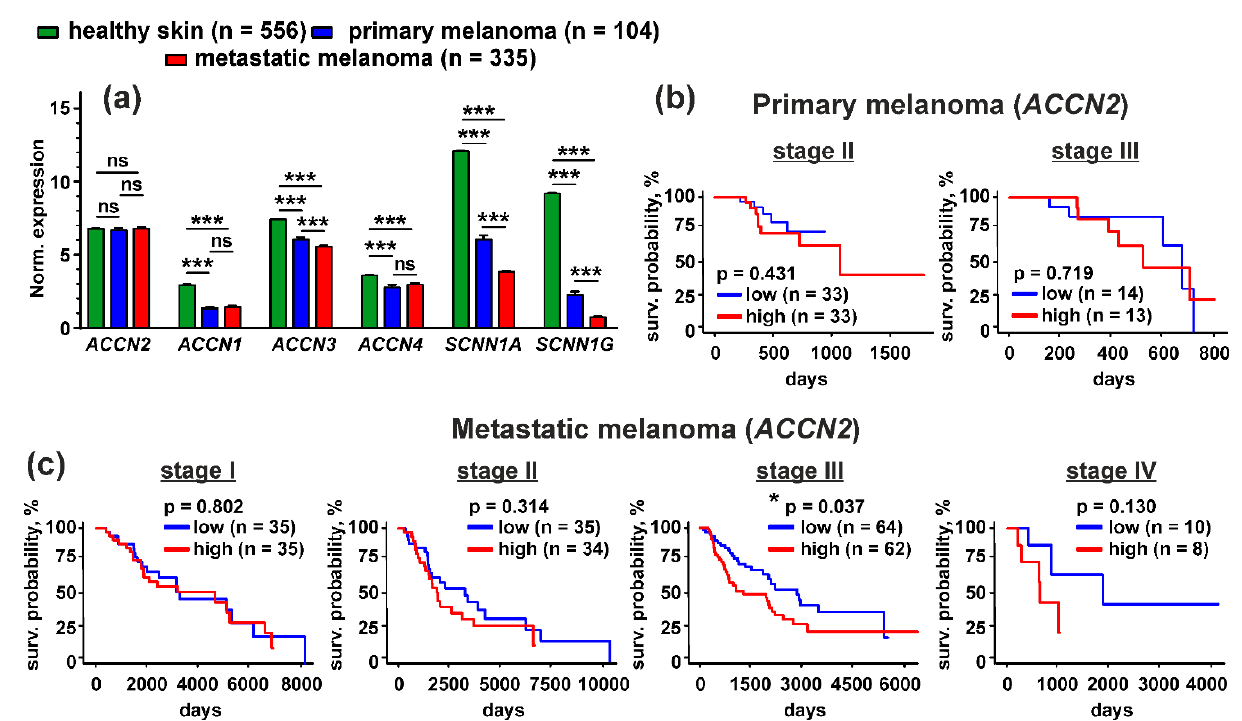
Figure 11. Bioinformatic analysis of the ACCN2 , ACCN1 , ACCN3 , ACCN4 , SCNN1A, and SCNN1G expression in healthy people and patients with non-glabrous primary and metastatic melanoma from the GTEX and TCGA SKSM databases: ( a ) analysis of the gene expression in healthy skin biopsies (GTEX study) and in samples of primary and metastatic melanoma (TCGA SKSM study). Data are presented as normalized gene expression ± SEM, *** ( p < 0.001) indicates significant difference between the data groups by One-Way ANOVA followed by Dunnets’ hoc test; ( b , c ) Kaplan–Meier analysis of survival of the patients with primary ( b ) and metastatic ( c ) melanoma and different expression of the ACCN2 gene. * ( p < 0.05) indicates significant difference between the survival prognosis for patients with the high (above median) and low (below median) ACCN2 expression according to log-rank test.